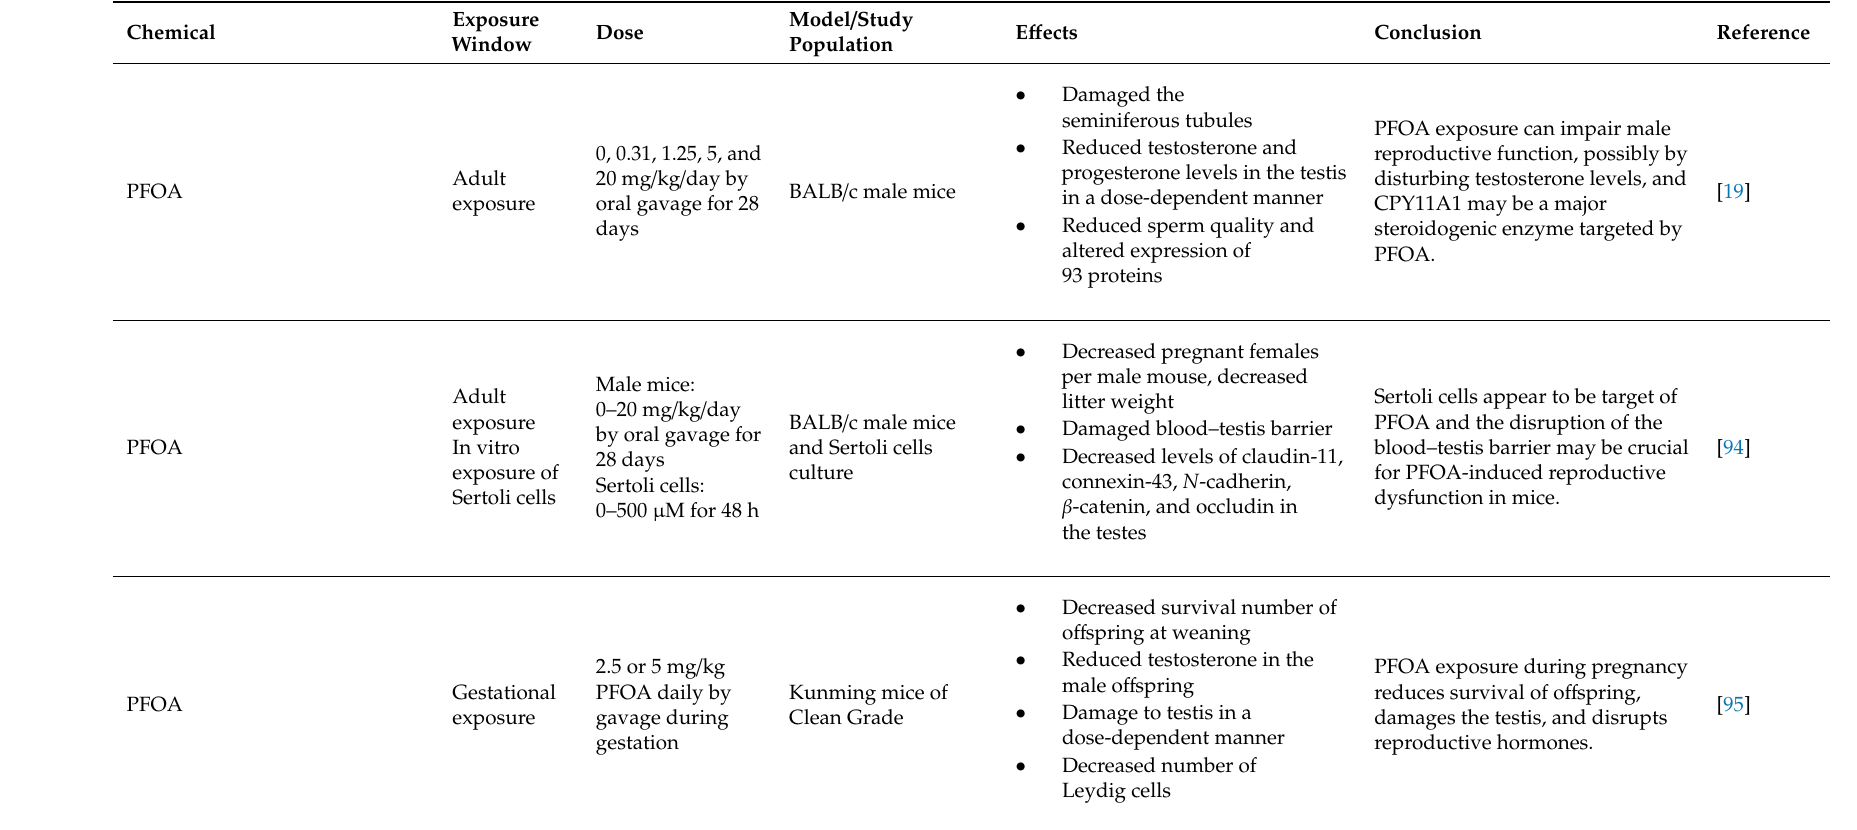
Table 4. E ff ects of PFAS on the Reproductive